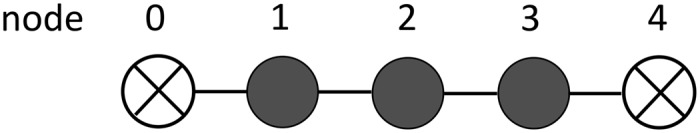
The one-dimensional morphology example with three material nodes bounded by two empty nodes.